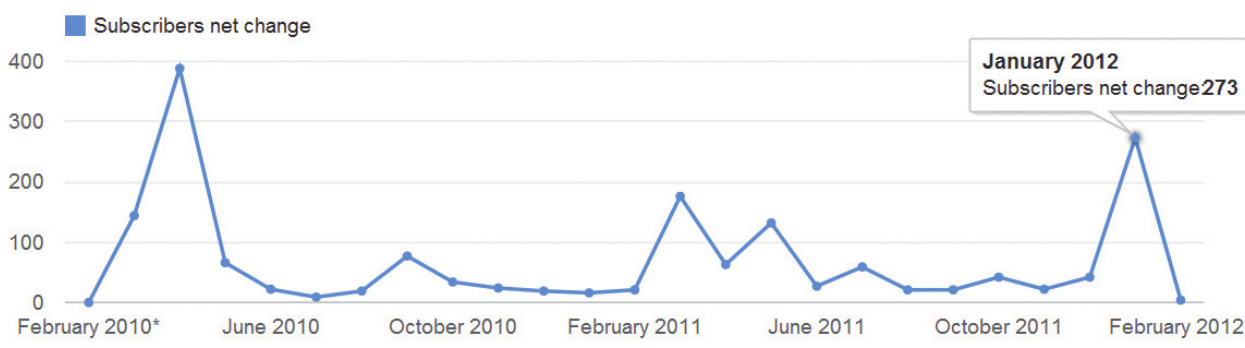
Figure 6. Number of shared videos per month for the INGV YouTube channel from the opening* to date*. Note that before the March-May 2011 period, the monthly averages were near zero, while in the following months they were around 10-25, with a relevant peak in January 2012 (106